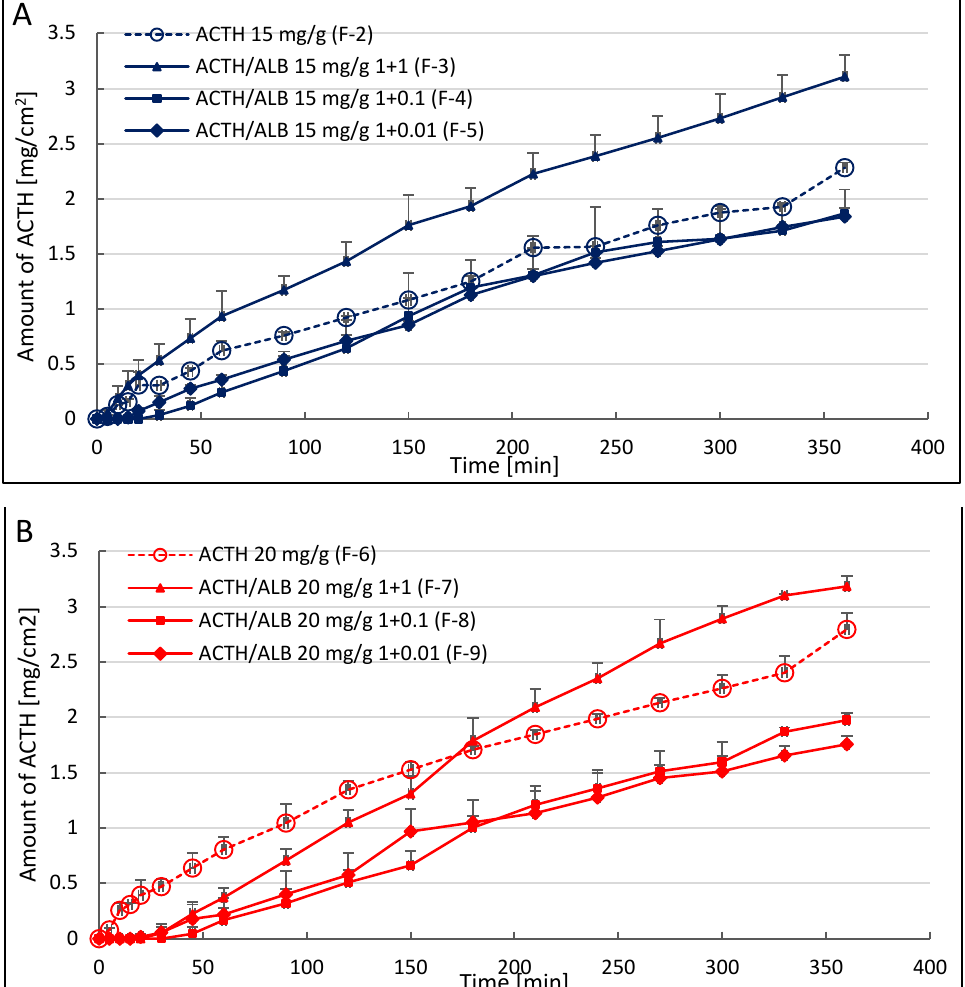
Figure 2. Corticotropin (ACTH) release profiles for formulations with ACTH at 15 mg/g (F-2) and ACTH at 15 mg/g and albumin (F-3–F-5) ( A ) and for formulations with ACTH at 20 mg/g (F-6) and for formulations with ACTH at 20 mg/g and albumin (F-7–F-9) ( B ). The Weibull method ( p < 0.05) showed statistically significant differences in